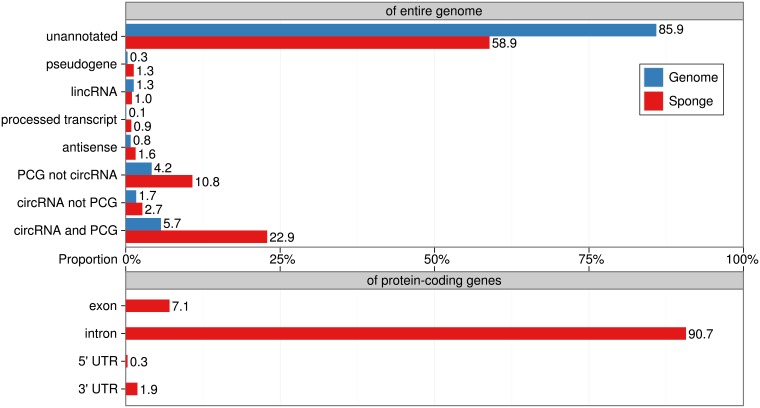
Genomic context of the sponge candidates.The upper bar chart shows the percentage for the different types of transcripts in the genome based on GENCODE and circBase, and their percentage within our sponge predictions are calculated after we assign annotations to the predicted sponge candidates. For each type of transcript, we calculate the percentage of their nucleotides under whole genome and annotated sponges. Then we can evaluate the enrichment via comparing the percent between sponges and whole genome. There is big overlap between PCGs and circRNAs, so we further divide them into “PCG not circRNA”, “circRNA not PCG” and “circRNA and PCG”. They refer to PCGs not overlapping with circRNAs, circRNAs not overlapping with PCGs, and PCGs overlapping with circRNAs, respectively. The lower bar chart shows the percentage of nucleotides located in intron, exon, 3’ UTR, and 5’ UTR for all annotated PCG sponge candidates. All percentages are calculated based on the number of nucleotides, excluding masked repeats, and are strand-sensitive.